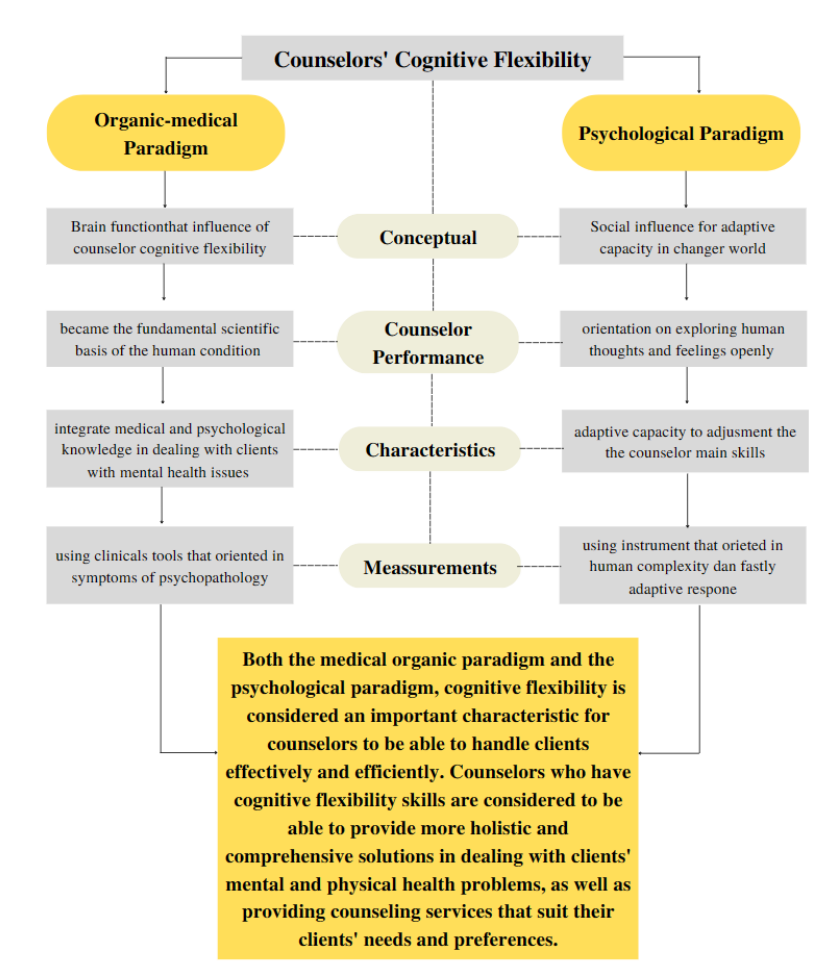
Fig 4. The Intersection of Organic-Medical and Psychological Paradigms in Assessing the Cognitive Flexibility of